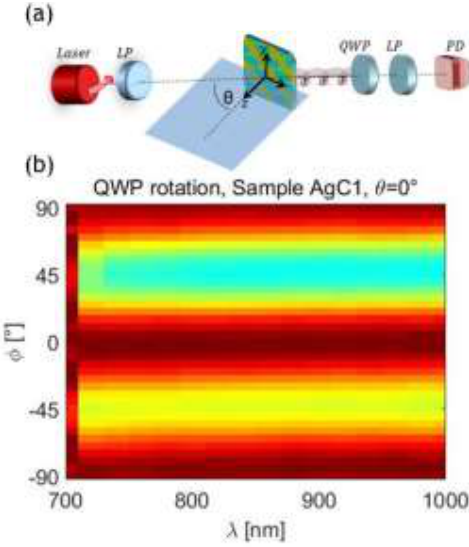
Fig. 1. (a) Set-up for the measurement of angle-dependent, spectrally tuneable circular polarization degree in the output. (b) Wavelength-QWP angle transmission map at normal incidence.